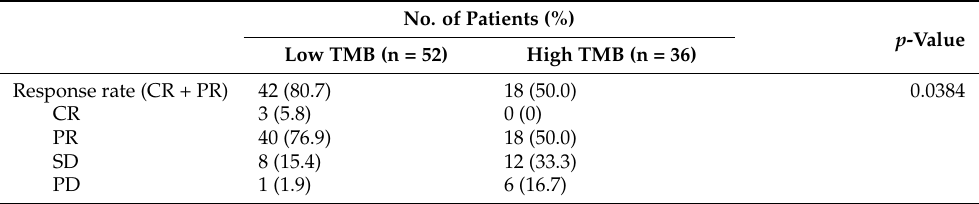
Table 2. Treatment response according to the different TMB levels.